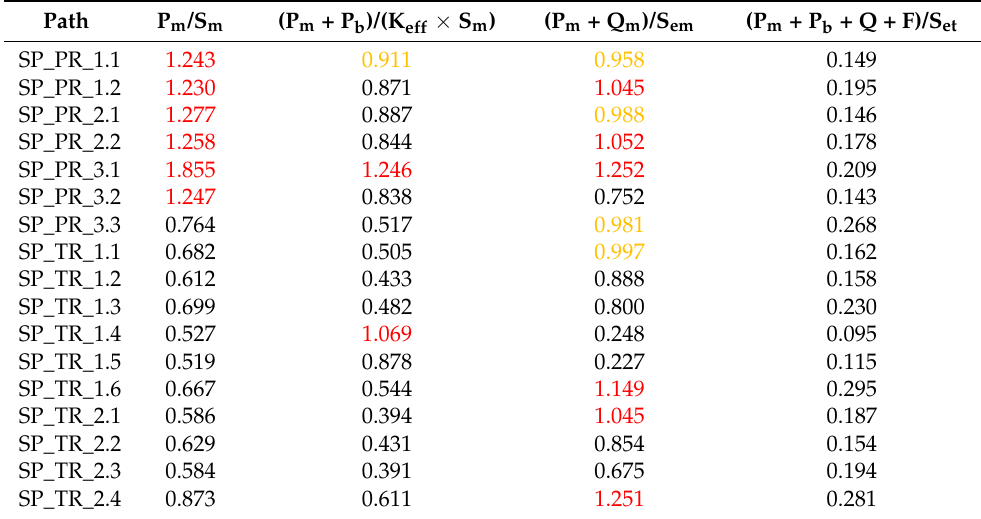
Table 3. RCC-MRx Level D criteria verification within SPs domain.